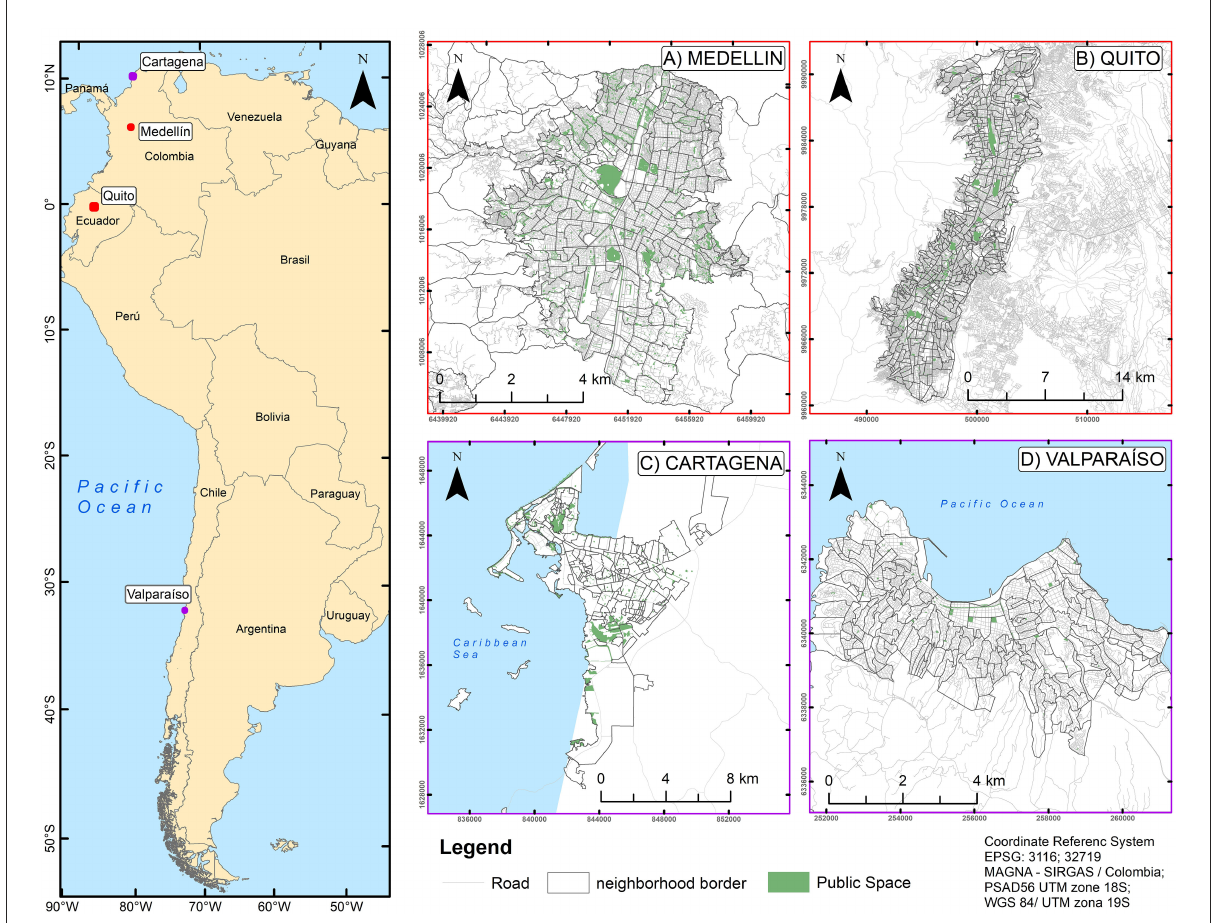
FIGURE1 Case studies: Location and distribution of public spaces in (A) Medellín, (B) Quito, (C) Cartagena, and (D) Valparaiso. Source: Prepared by the authors based on (Decreto 0977 de, 2001; Acuerdo 48 de, 2014; Cárdenas et al., 2020; Alcaldia de Medellin, 2021; Alcaldia de Quito, 2021b; Alcaldia Mayor de Cartagena de Indias, 2021; Ministerio de Vivienda y Urbanismo de Chile,